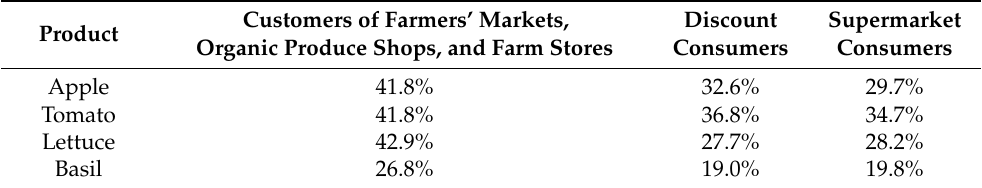
Table 4. Proportion of respondents rating the iodine-biofortified fresh products presented as very appealing as affected by the location of purchase. ( n =